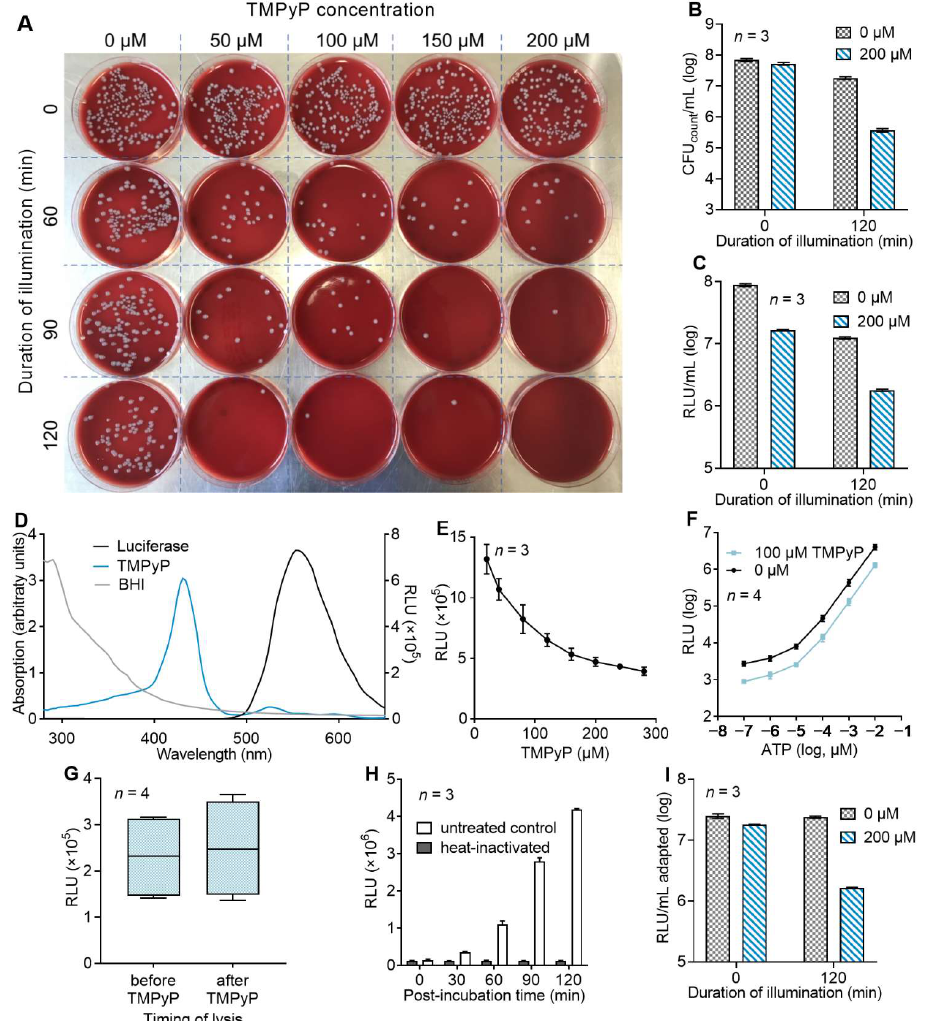
Figure 1. ATP-based luminometry as a novel approach to measure aPDI effects in vitro. ( A ) E. coli bacteria were treated with TMPyP at the indicated concentration and exposed to light (13 mW/cm 2 at λ cent = 420 nm; 0.78 J/cm 2 per minute) for the indicated durations. Bacteria were spread on blood agar plates (dilution factor 10 − 5 ) and incubated for 20 h (37 ◦ C, 5% CO 2 ). ( B ) aPDI effect of the experiment described in A without or with 200 µ M TMPyP determined as CFU count /mL. ( C ) E. coli were incubated without or with 200 µ M TMPyP and treated for 0 or 120 min with light as described in A. Bacterial viability was determined by ATP-induced luminescence in bacterial lysates. ( D ) Absorption spectrum of 40 µ M TMPyP dissolved in 50% BHI bacterial growth medium dissolved in 0.9% NaCl solution. Additionally, the luminescence spectrum of the luciferase used in the cell viability assay and absorption spectrum of the BHI medium are displayed. ( E ) Effect of different TMPyP concentration on ATP-induced luminescence; TMPyP at indicated concentrations was supplemented with 5 nM ATP (in 0.9% NaCl solution) and ATP-induced luminescence was determined ( n = 3). ( F ) Luminescence elicited by ATP at the indicated concentrations (in 0.9% NaCl) in the presence or absence of 100 µ M TMPyP ( n = 4). ( G ) Effect of TMPyP on bacterial ATP metabolism. E. coli suspended in 50% BHI were lysed before or after addition of 200 µ M TMPyP ( n = 4). ( H ) E. coli suspended in 50% BHI broad medium were heat-inactivated or left untreated and incubated at 37 ◦ C, 5% CO 2 in the same solution as active bacteria for the indicated duration. Bacteria were lysed, and luminescence was measured with the cell viability assay ( n = 3). ( I ) aPDI effect of the experiment described in C with 200 µ M TMPyP, measured 90 min after incubation (37 ◦ C, 5% CO 2 ) and adjusted to highest PS concentration (200 µ M) in all samples prior to